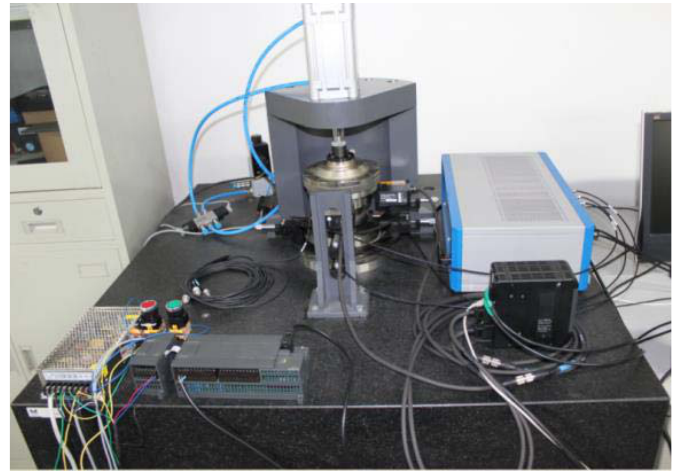
Figure 11. Ultra ‐ precision rotational accuracy experimental platform. Figure 11. Ultra-precision rotational accuracy experimental